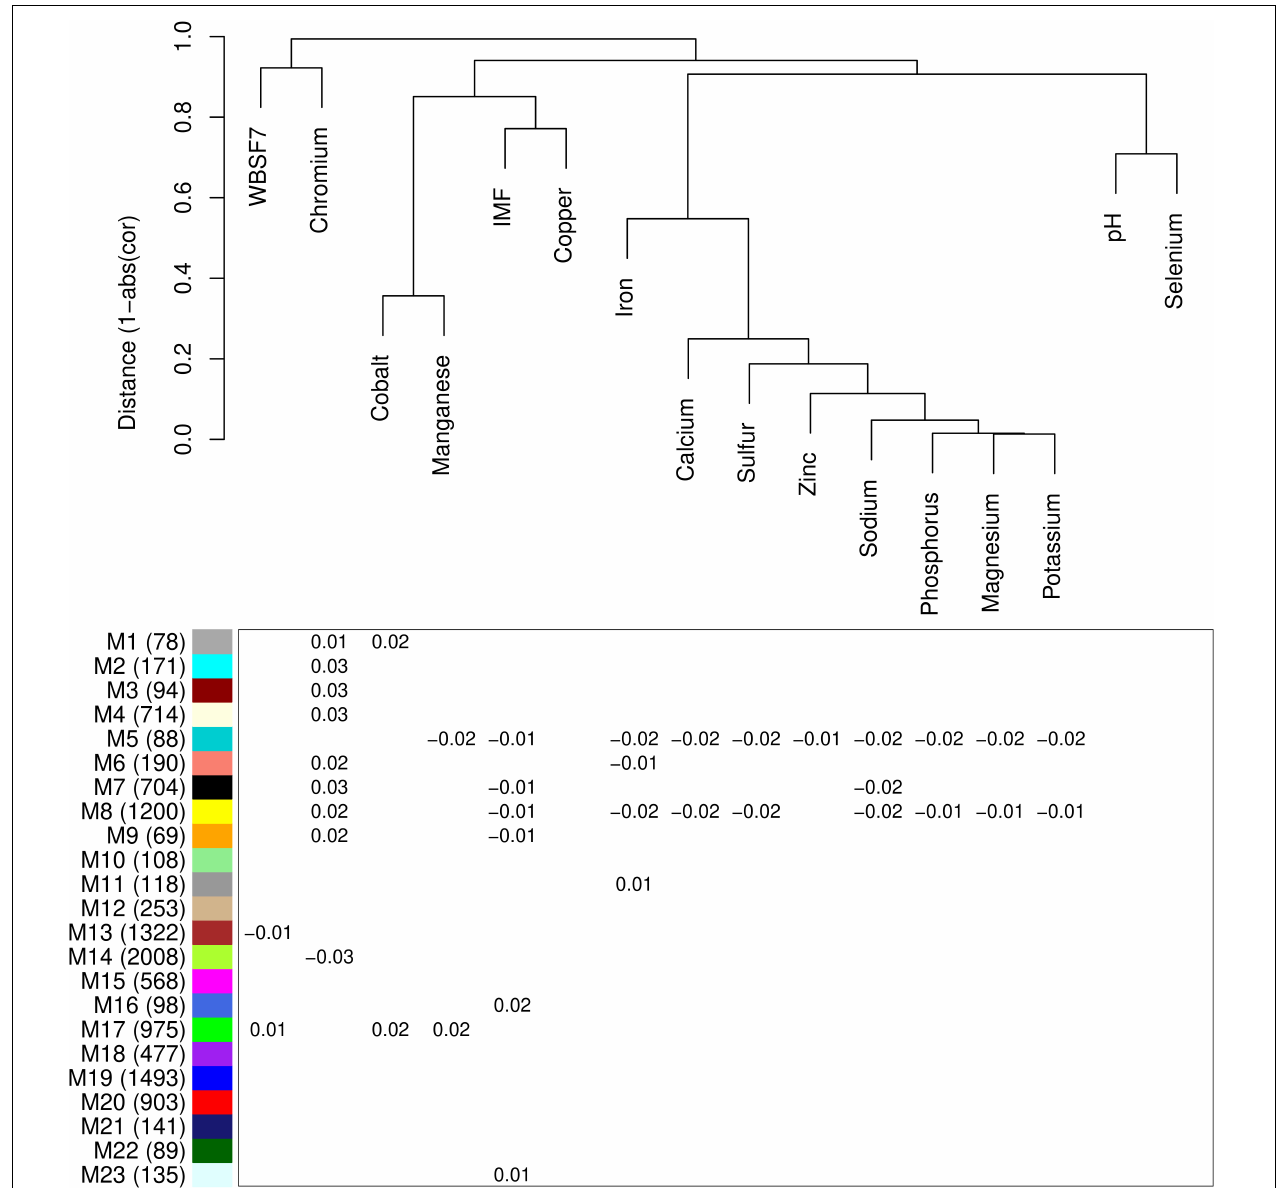
FIGURE 3 | Hierarchical clustering of phenotypic correlation between traits (top) and module-trait association analysis (bottom). Modules are labeled by number on the y -axis with the number of contained genes in parenthesis. Each column represents a trait as indicated on the corresponding dendrogram branch. For significantly associated modules ( p ≤ 0.05), the coefficient from the linear model is given within the